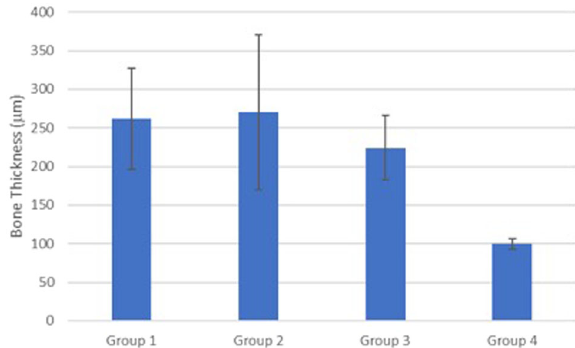
Fig. 15 Graph comparing the mean bone thickness in all the tested groups with the thickness of native non-operated bone (100 µm). A signi fi cant difference was found at p value <